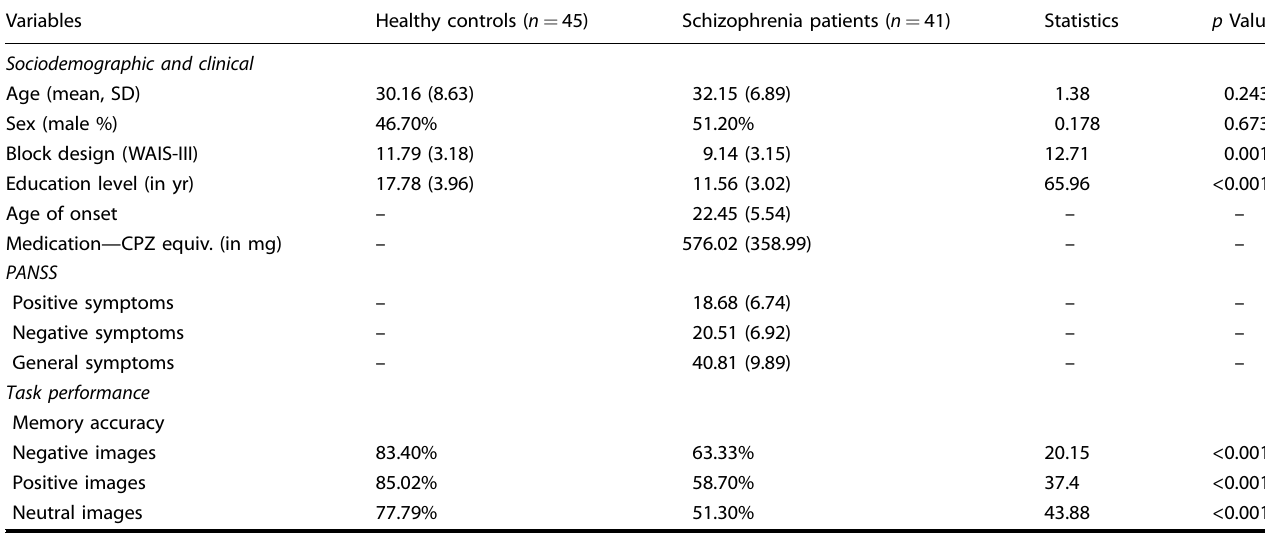
Table 1. Sociodemographic, clinical, and task performance characteristics of the